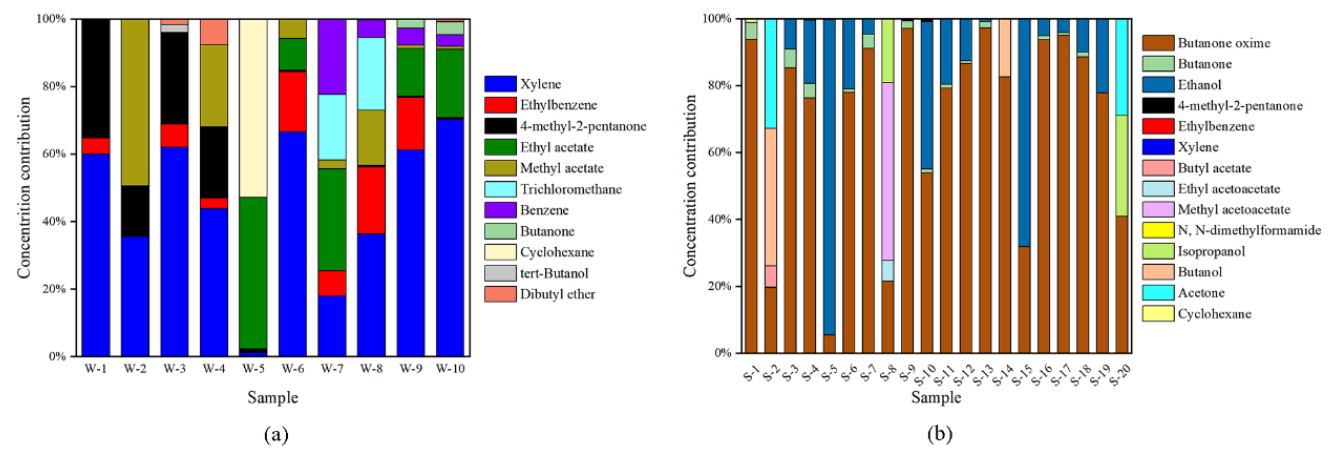
Figure 1. Box diagram of concentration distributions of the compounds emitted from white emulsion adhesives ( a ) and silicone adhesives ( b ).